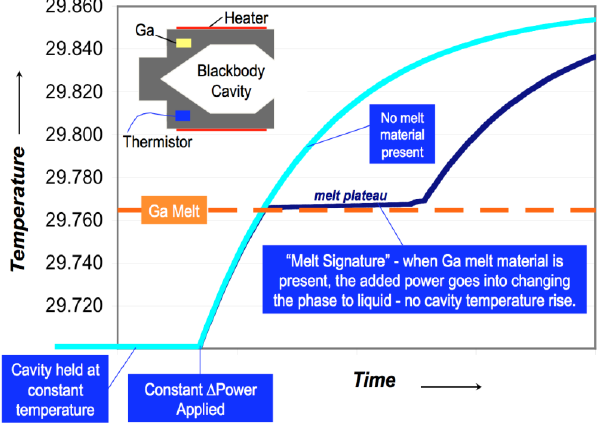
Figure 18. The sequence of events during a typical melt of gallium confined in a phase transition cell and imbedded into an OARS as illustrated in Figure 17. After initial stabilization in the constant temperature mode, a constant power is used to transition through the melt plateau.